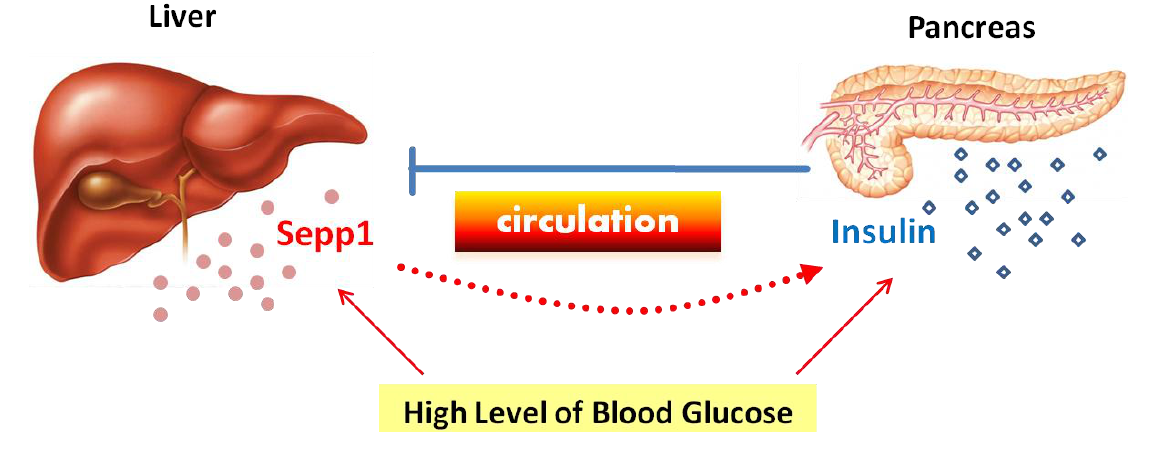
Figure 1. Feedback regulation between hepatic Sepp1 and pancreatic insulin under the normal insulin-sensitive condition. Circulating high glucose concentration stimulates the expression of insulin in the pancreas and Sepp1 in the liver. If the increasing Sepp1 is transported into the pancreas and collaterally enhances insulin production, then sufficient insulin may feedback to inhibit hepatic Sepp1